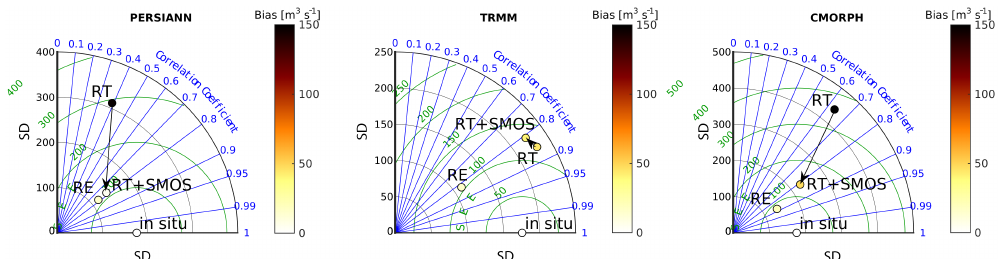
Figure 9. Taylor diagrams of the streamflow performances for the three rainfall products (PERSIANN on the left, TRMM in the middle, CMORPH on the right) using their real-time version only (RT), their reanalyzed version (RE), and the RT version after SMOS assimilation (RT + SMOS). The arrow shows the changes in the statistics before and after SMOS